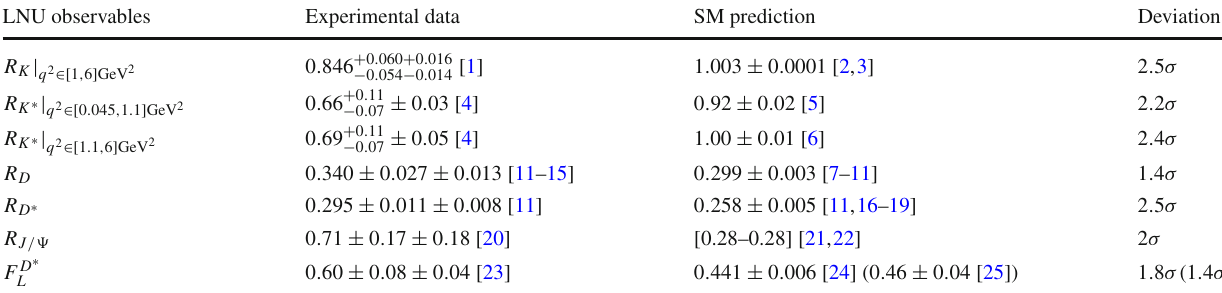
Table 1 List of the measured LNU observables LNU